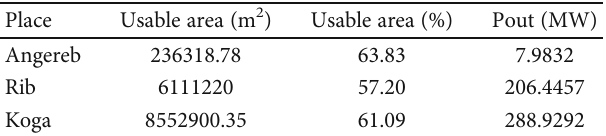
Table 8: Usable water surface area in percent generation power potential of each irrigation